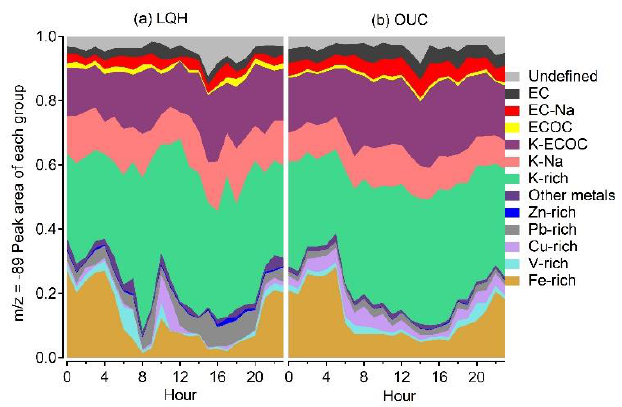
Figure 4. Average diurnal variations in classified oxalate groups (contribution of m / z − 89 PA from each classified group to that of the total oxalate particles) at ( a ) LQH and ( b ) OUC.